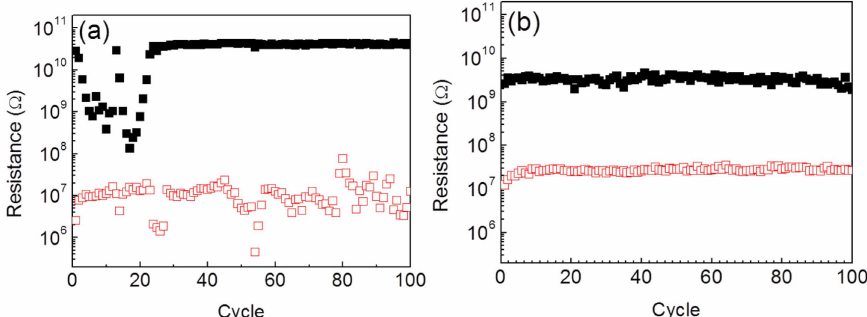
Figure 3. Endurance tests of the ZnO NW–based memories ( a ) without and ( b ) with argon plasma treatment.